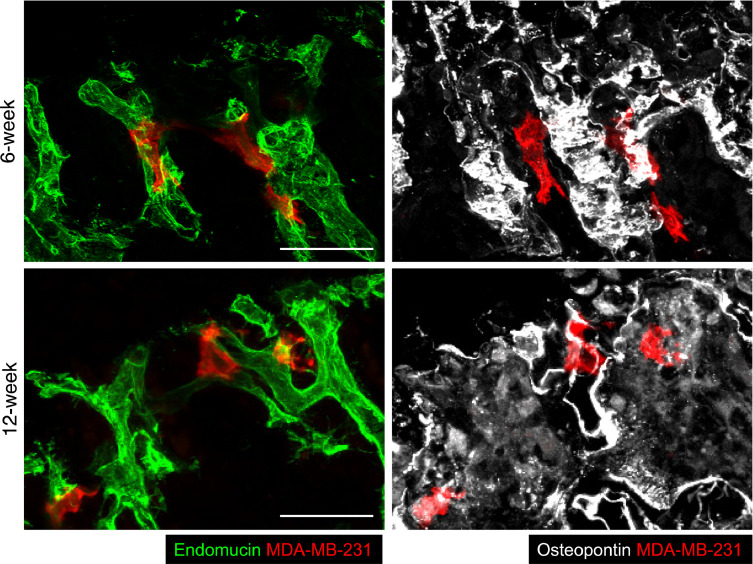
Disseminated breast cancer cells reside in perivascular locations within mouse long bones. Immunofluorescent labelling of tibial cryosections from young and mature mice containing human MDA-MB-231 breast cancer cells with antibodies against the vascular marker Endomucin, the bone marker Osteopontin and two human antigens expressed by MDA-MB-231 cells. The samples were prepared 6 days after intra-cardiac injection of tumour cells (scale bar = 50 µm). (For interpretation of the references to color in this figure, the reader is referred to the web version of this article.)